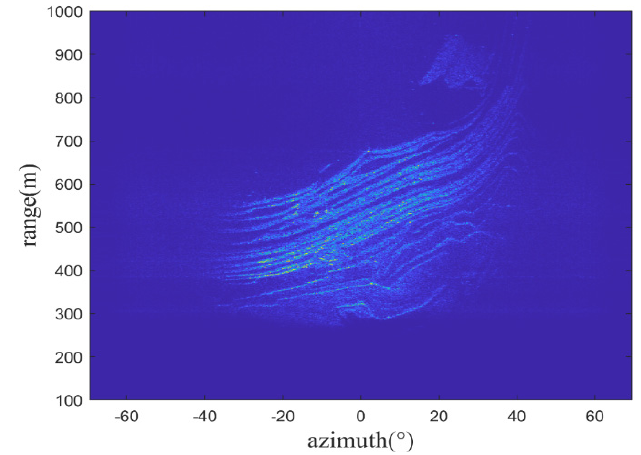
Figure 3. Radar image of monitored scene.